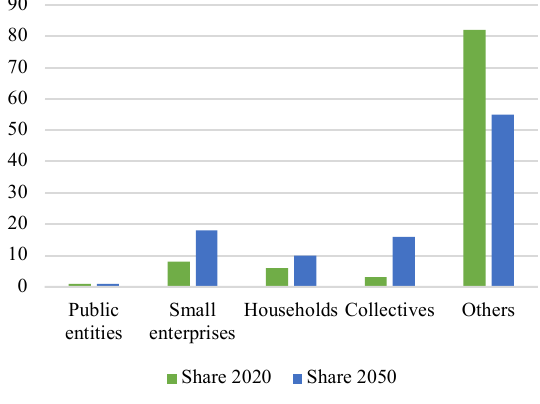
Fig. 2. Share of electricity production by investor type in